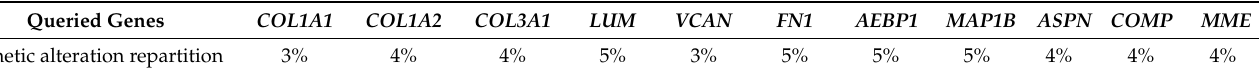
Table 2. Genetic alteration of our selection of connective tissue genes in the TCGA cohort.